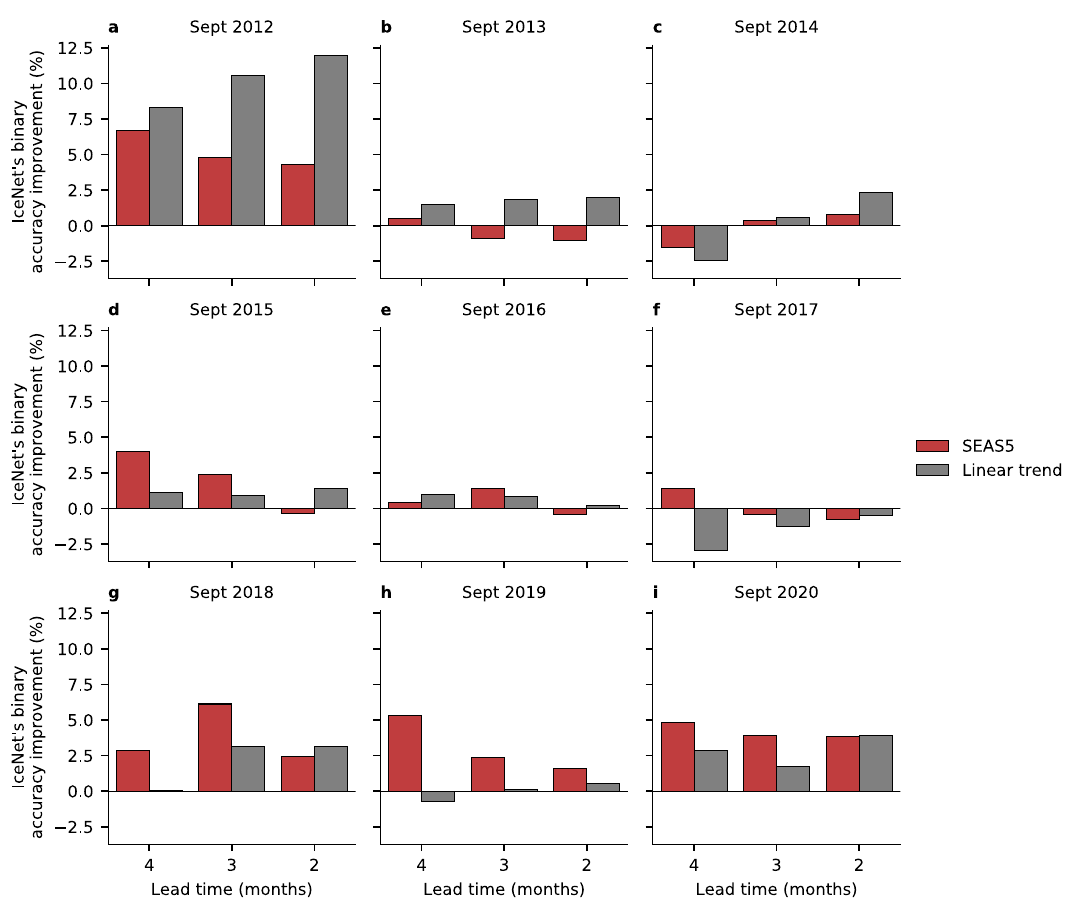
Fig. 4 Comparing IceNet with SEAS5 and the linear trend for seasonal September forecasts. a – i IceNet ’ s improvement in binary accuracy relative to SEAS5 and the linear trend models for September forecasts at 4- to 2-month lead times for the validation and test years (2012 –